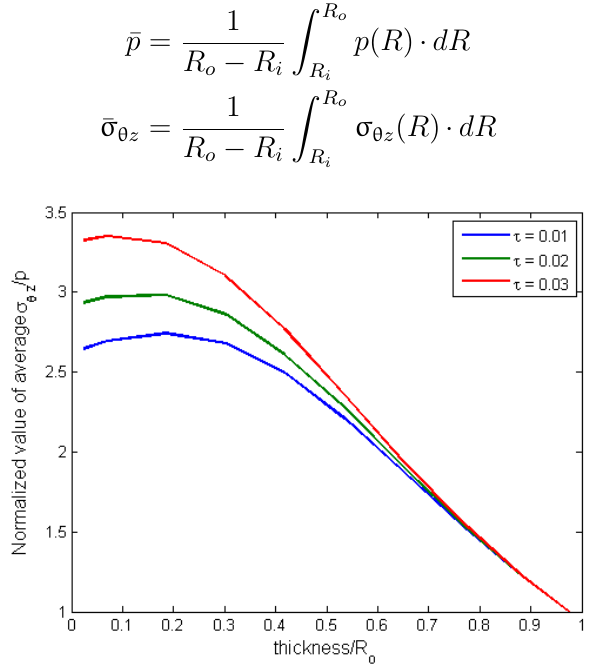
/ ¯ p as a function of thickness/ R θ z